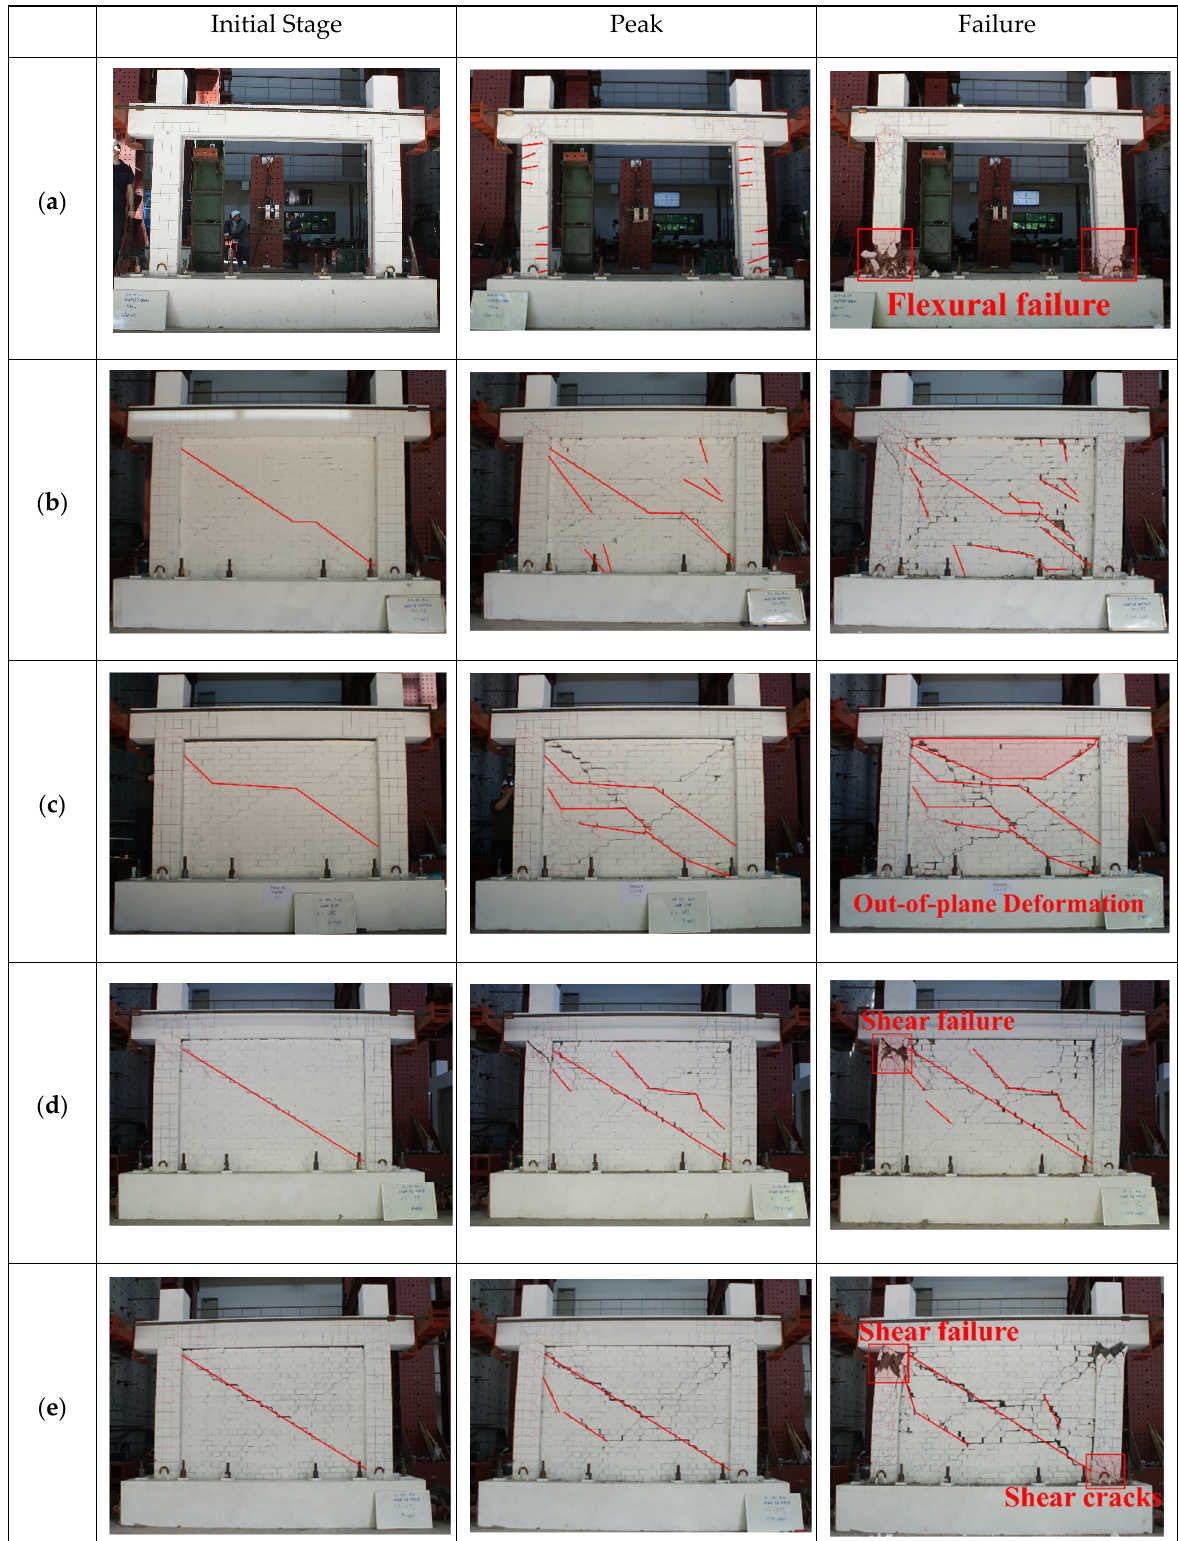
Figure 6. Crack patterns and failure modes. ( a ) BF. ( b ) IF-0.5. ( c ) IFS-0.5. ( d ) IF-1.0. ( e ) IFS-1.0.